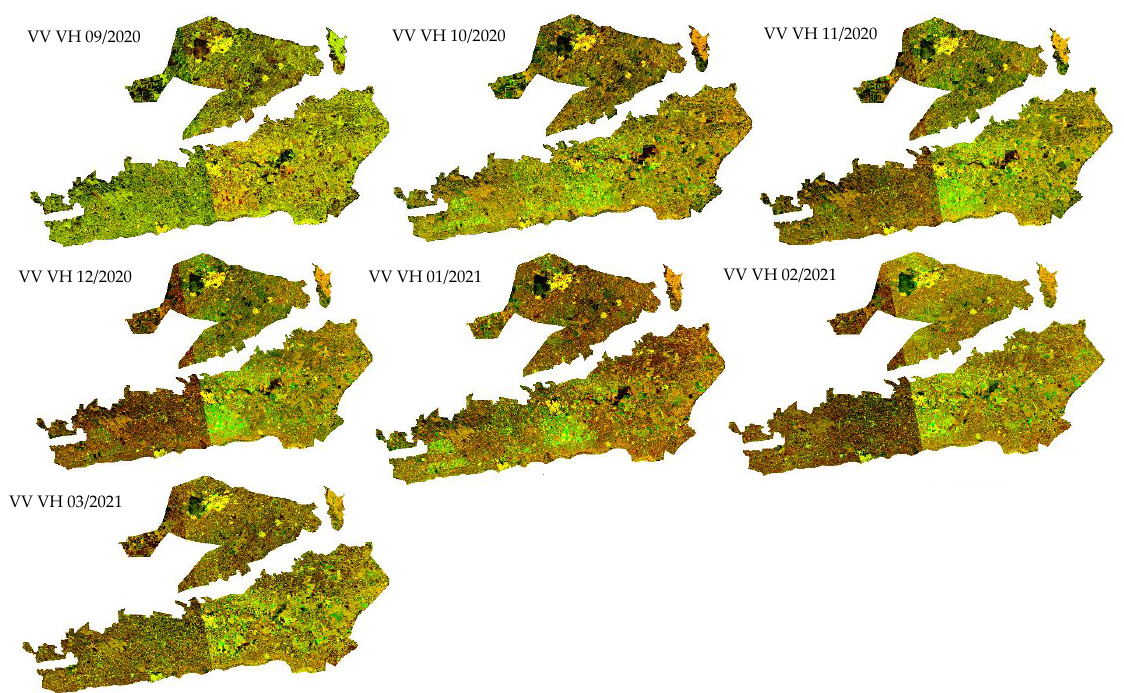
Figure 6. Backscattering monthly images from September 2020 to March 2021 of the Tadla Irrigated Perimeter (TIP).